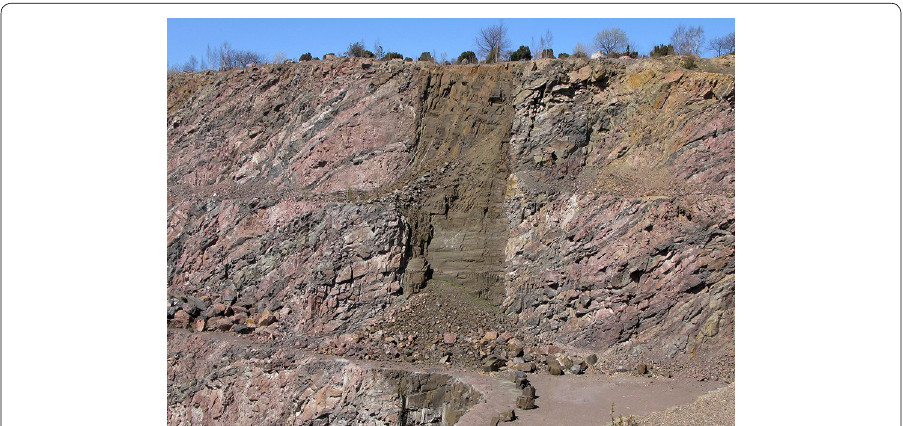
Fig. 3 Photo from Dalby quarry exemplifying the rock mass composition with severely fractured reddish gneiss and numerous variably thick dykes and schlieren of metabasite. The photo also shows a subvertical brownish black Permo‑Carboniferous dolerite dyke cutting through the host rock. Photo: L.